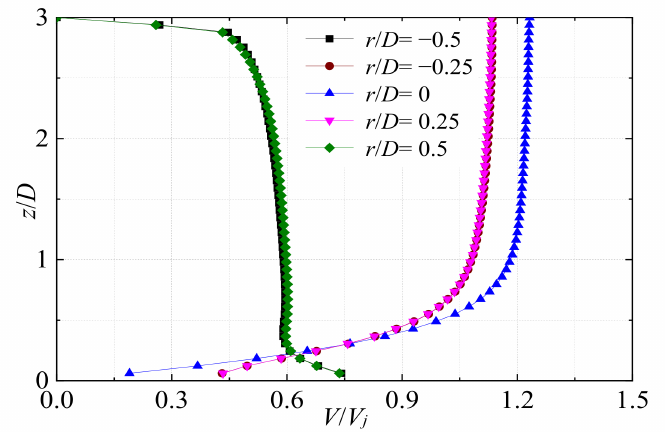
Figure 10. Axial distribution of velocity V/V j at different radial positions of the cross-section in the